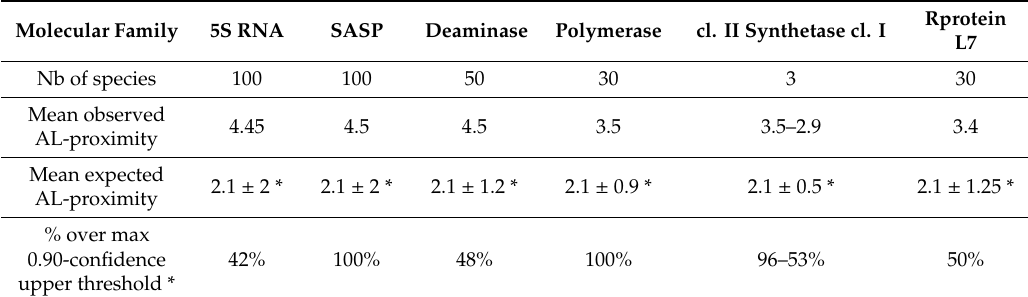
Table 1. ALPHA proximity. The more the molecules considered are essential for protein translation, the greater is their ALPHA pentameric proximity P 22 (calculated on the 22 pentamers of